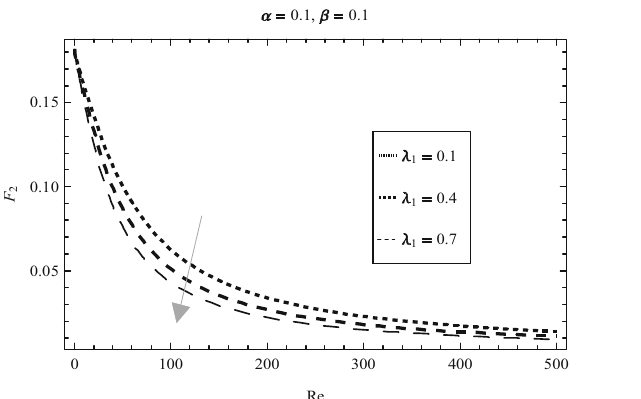
Fig. 23 Variation of F 2 along Re for different values of λ 1 Table 1 The values of skin friction component (τ z ) for ε = 0 . 2 and z = 0 . 5 Values of Re Value of τ z in the paper under consideration Values of τ z in the paper [12] 0.1 0.35621585675326073 0.35621 0.2 0.3528602106014592 0.35286 0.3 0.3495151161671338 0.34951 0.4 0.3461814949165511 0.34618 0.5 0.3428602555461267 0.34286 0.6 0.33955229259306274 0.33955 0.7 0.33625848508717837 0.33625